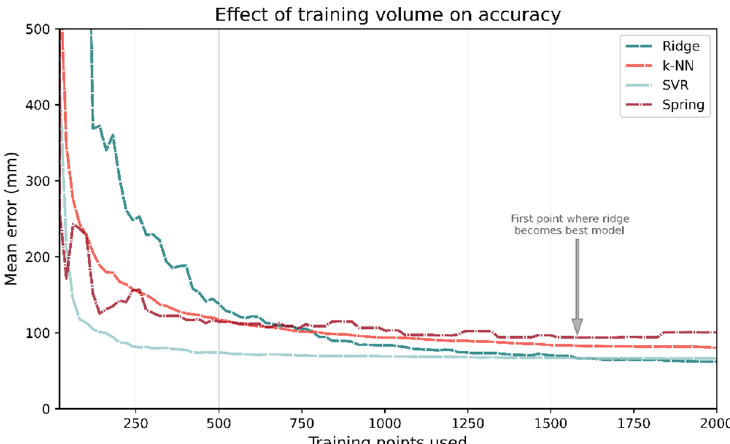
Figure 22. The number of training points used has a large impact on which model has the best performance. Despite being the best performing model when trained on the entire data set, Ridge regression requires a significant number of training data. It takes 1580 training points before Ridge regression becomes the best performing model.